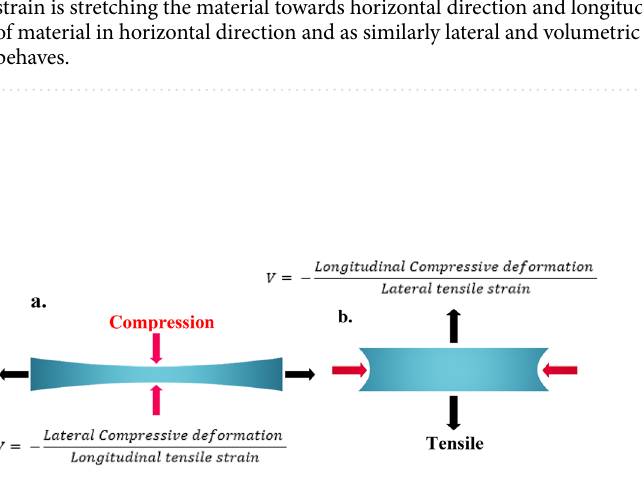
Figure 3. Schematic representation of Poisson’s ratio effect for the induced longitudinal and lateral strains. ( a ) For the applied longitudinal tensile strain and then along with longitudinal stretching (horizontal stretching), there will also be a small compressive deformation along orthogonal direction due to Poisson’s ratio ( V ) effect of material and it is defined by the expression below ( a ). ( b ) For the applied lateral tensile strain and then along with lateral stretching (vertical stretching), there will also be a small compressive deformation along orthogonal direction due to Poisson’s ratio ( V ) effect of material and it is defined by the expression above ( b ). Here, in both the figures, we induced tensile (stretching) strain, and due to that the compressive deformation takes place. The deformation due to Poisson’s ratio ( V ) can also be a small stretching (tensile), when actual induced strain is